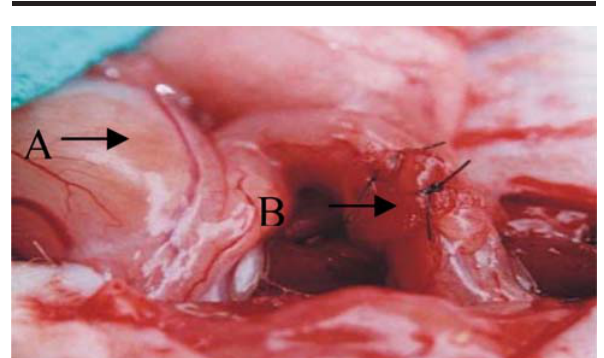
FIGURA 4 - Ilustração de inguinotomia à direita para implante do espécime no nível do funículo espermático. A - testículo e B - espécime implantado.